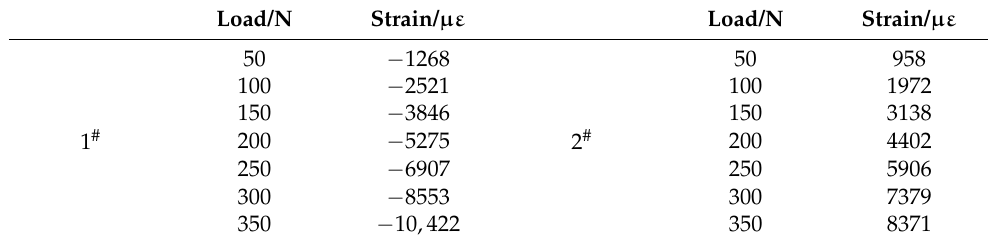
Table 3. Strain values of two test points under different loads.